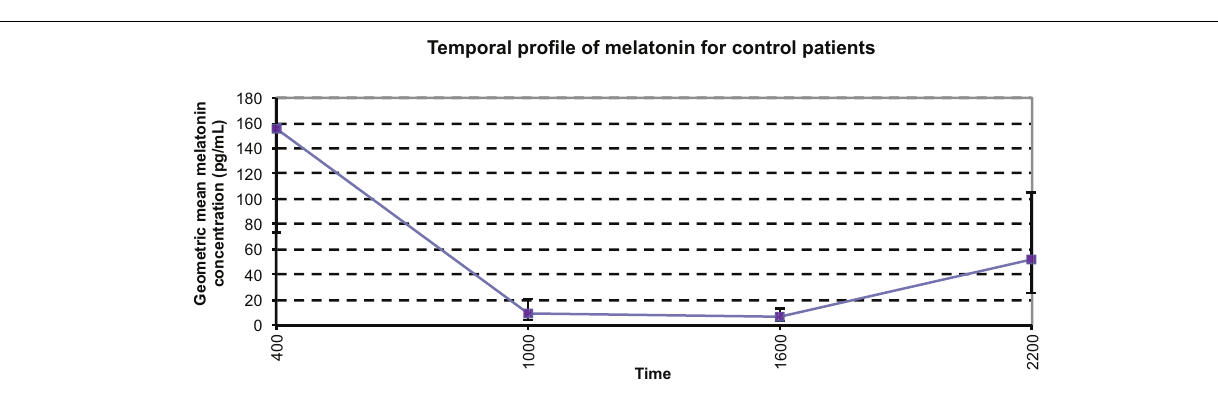
FIGURE 4 |Temporal profile of mean serum melatonin concentrations in controls, with a diurnal variation displaying maximum values at night, and minimum values during the day ( p < 0.0001) .The geometric mean concentrations for the control patients are significantly higher than those of the other patient